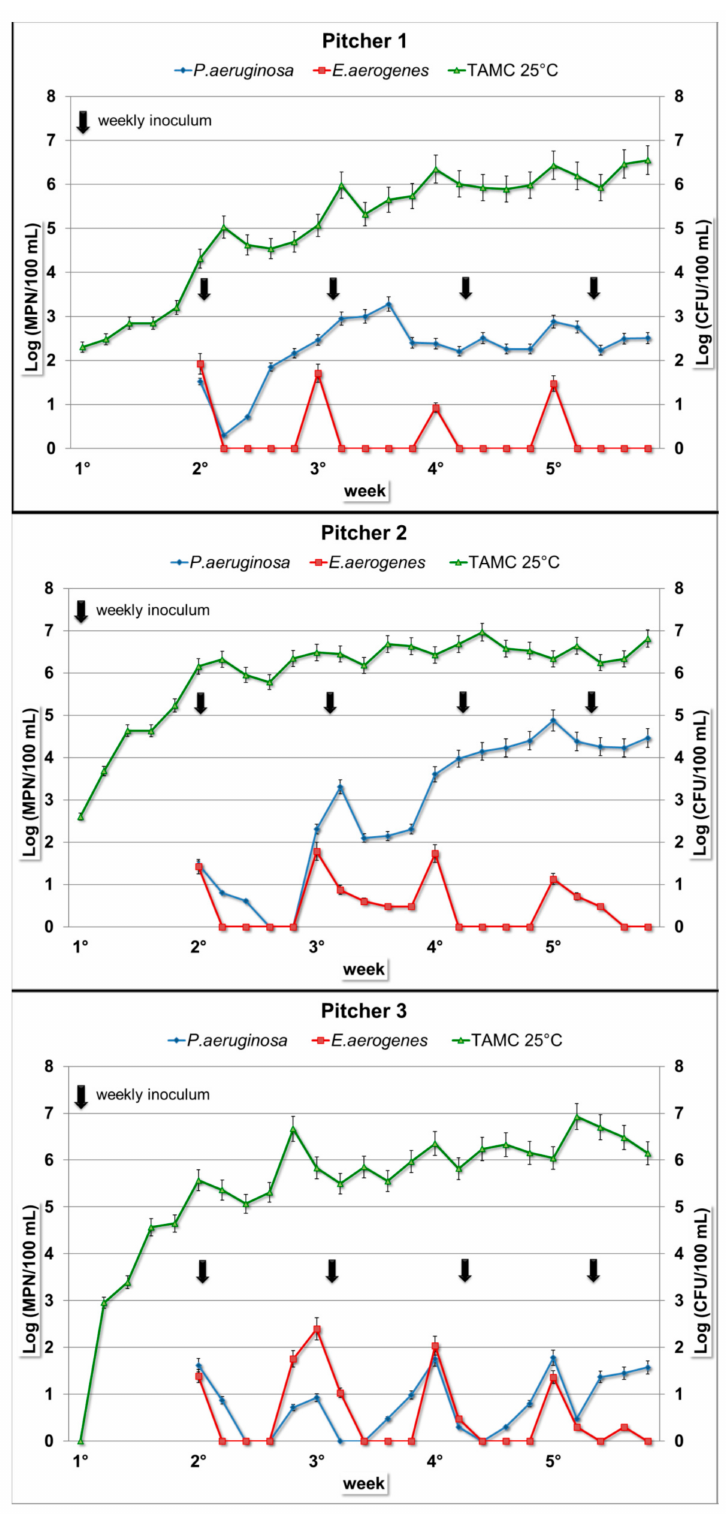
Figure 1. Bacterial concentration trends in daily composite samples in Filter Jugs 1–3. Arrows represent weekly inoculum for both bacteria ( E. aerogenes and P. aeruginosa ). The y -axes show: E. aerogenes and P. aeruginosa concentrations expressed in most probable number (MPN) / 100 mL (left); total aerobic microbial count (TAMC) at 25 ◦ C expressed in CFU / 100 mL